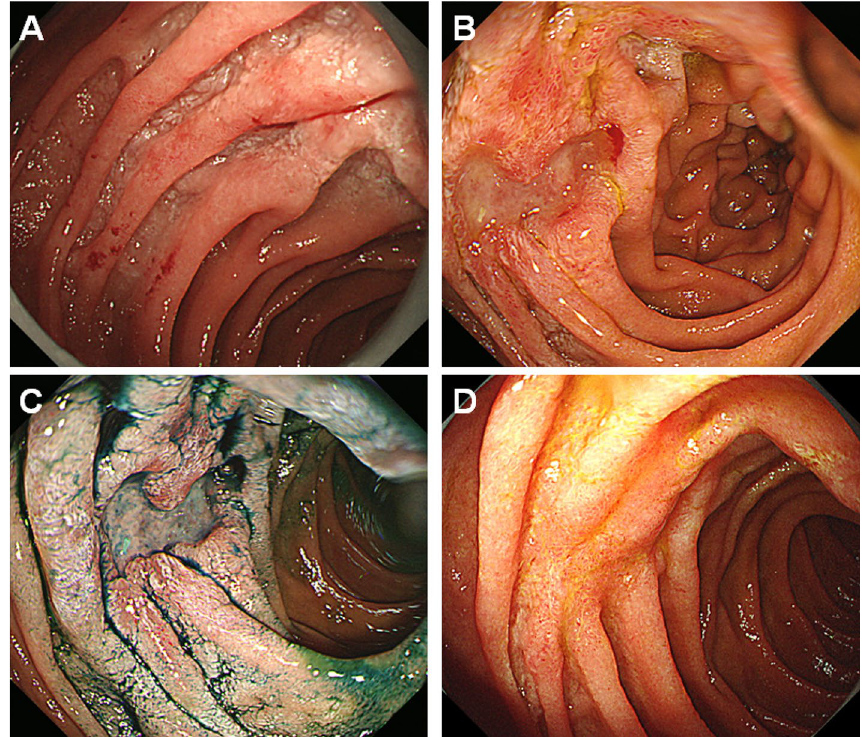
Figure 3. Endoscopy images of Case 3. A 64-year-old Japanese man was diagnosed with duodenal follicular lymphoma ( A ). The duodenal lesions were found to be ulcerative 2 years after the diagnosis ( B , C ) and disappeared after treatment with rituximab and bendamustine ( D ).